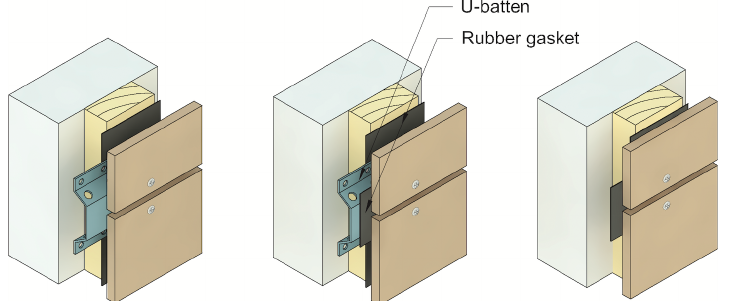
Figure 6. Profiles behind the joint, U-battens. From left: U-batten without a gasket, U-batten with a gasket, and with only a gasket. Normally, a vertical batten is not used in combination with an U-batten.